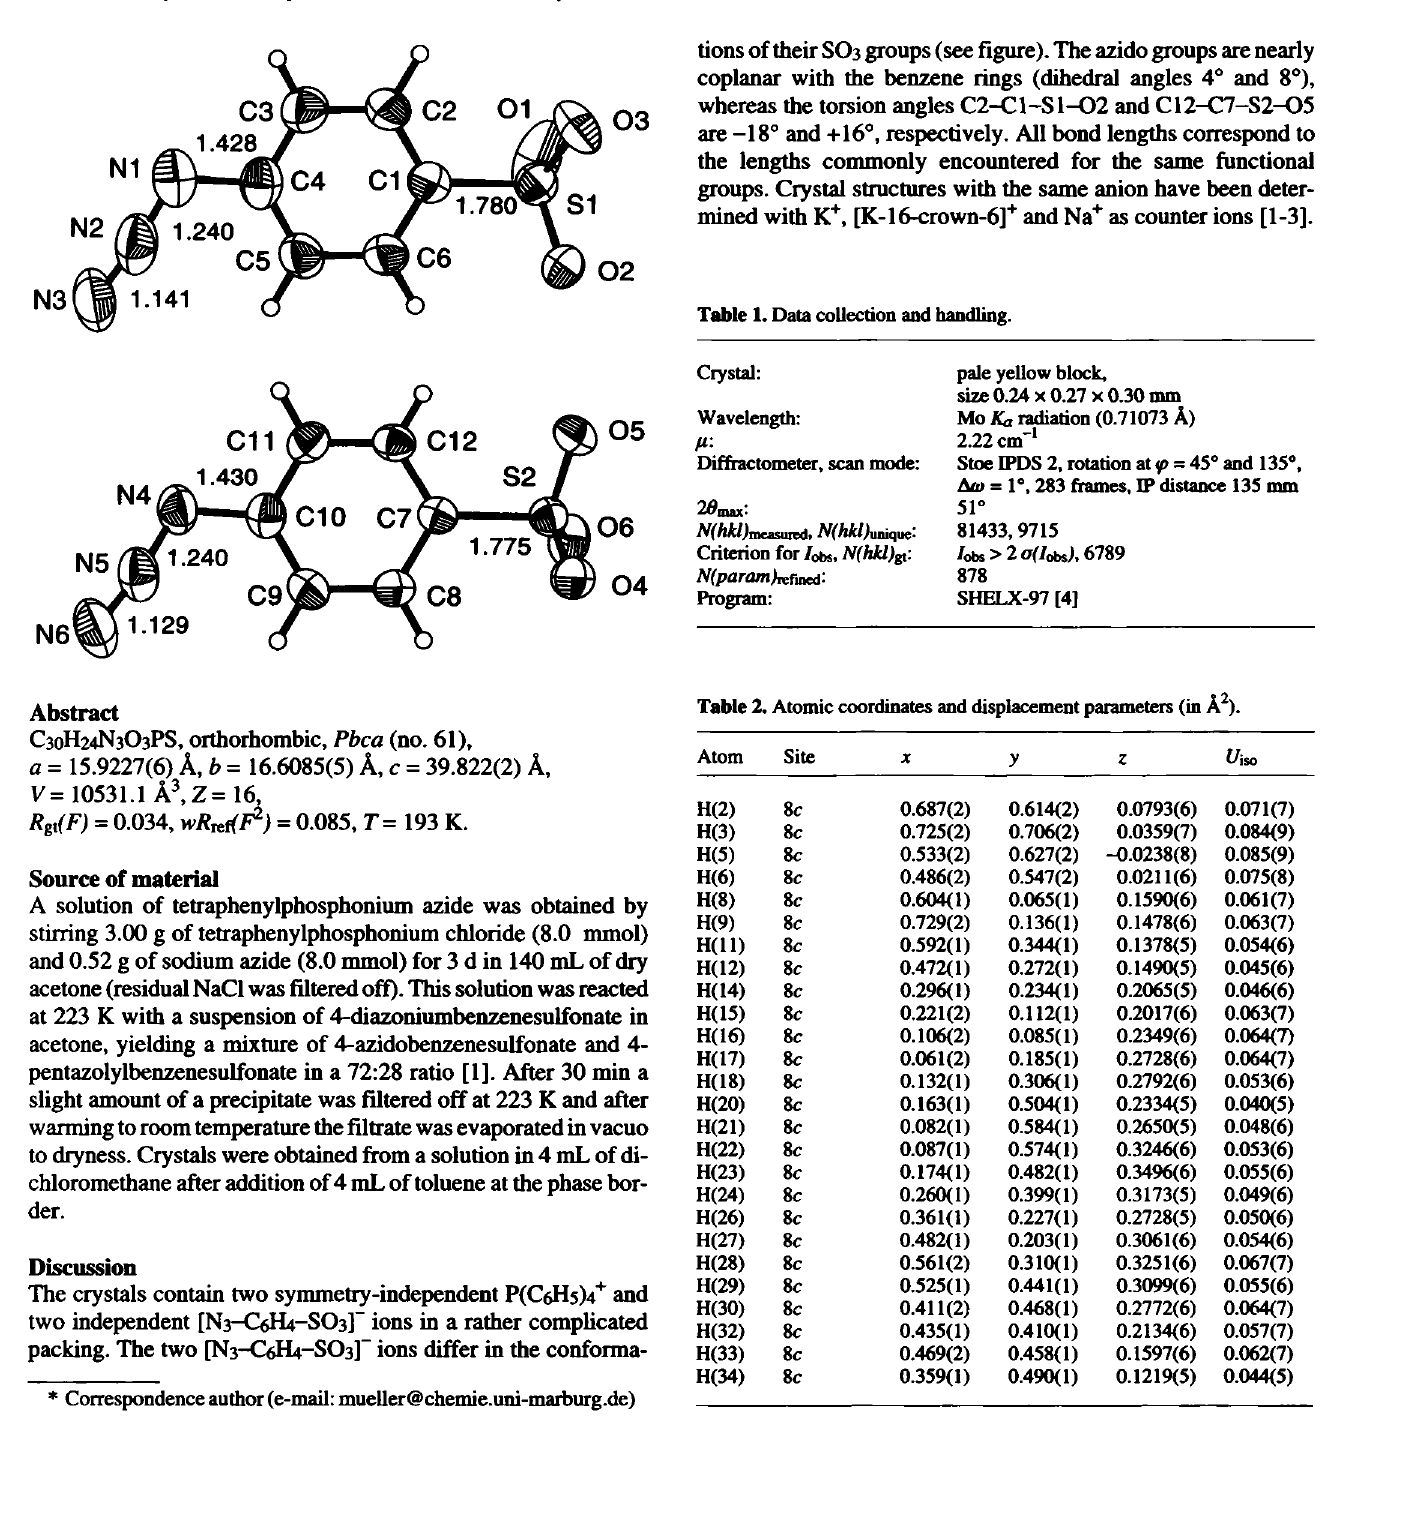
Table 1. Data collection and handling.